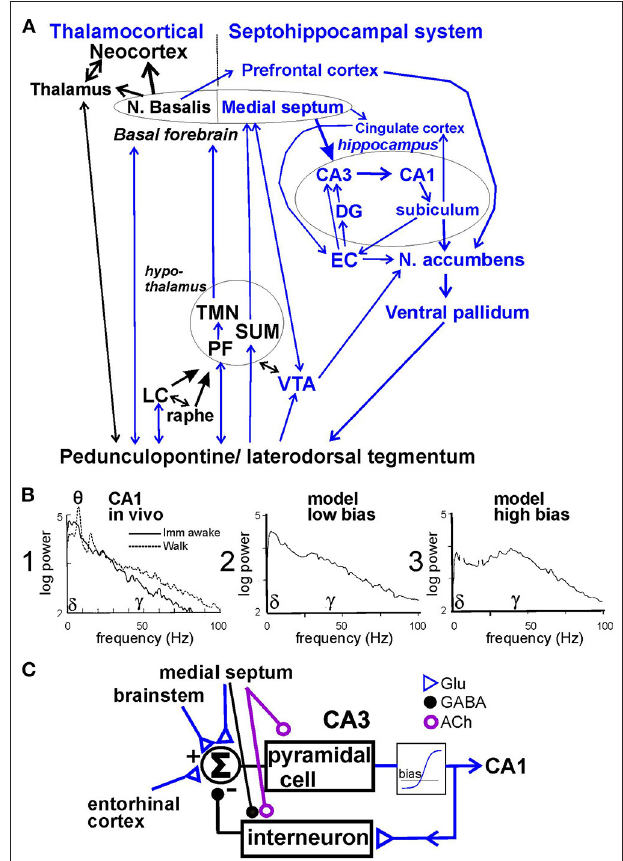
FIGURE 1 | (A) Schematic neural circuit for arousal and psychotic behaviors in septohippocampal and thalamocortical systems. Peduncolopontine tegmentum and lateral dorsal tegmentum project to monoaminergic nuclei [locus ceruleus (LC), raphe, and ventral tegmental area (VTA)] and hypothalamic areas [perifornical area (PF), tuberomammillary nucleus (TMN), and supramammillary area (SUM)] which also project to the basal forebrain (medial septum and n. basalis) and thalamus. The limbic cortices of hippocampus, entorhinal cortex (EC) receive afferents from the medial septum; cingulate and prefrontal cortices receive afferents from both the medial septum and n. basalis. Limbic cortices project to the nucleus accumbens (NAC) and then ventral pallidum, and back to the brainstem. NAC and ventral pallidum mediate behaviors. (B) 1. Power spectrum of hippocampal local field potentials recorded in CA1 stratum radiatum during awake immobility (imm) and walking in the rat; power was measured in (mV) 2 /Hz, and theta peak power corresponds to a theta amplitude of ∼ 1mV peak-to-peak. 2. Hippocampal residue spectrum (without theta peaks) is generated by model with low bias; and 3. with high bias. (C) Recurrent feedback model of pyramidal cells exciting inhibitory interneurons through a non-linear element, with bias level determined by background activity, and feedback gain modulated by the medial septum, adapted from Leung (1982). Glu, glutamatergic; GABA, gamma aminobutyric acid, ACh,